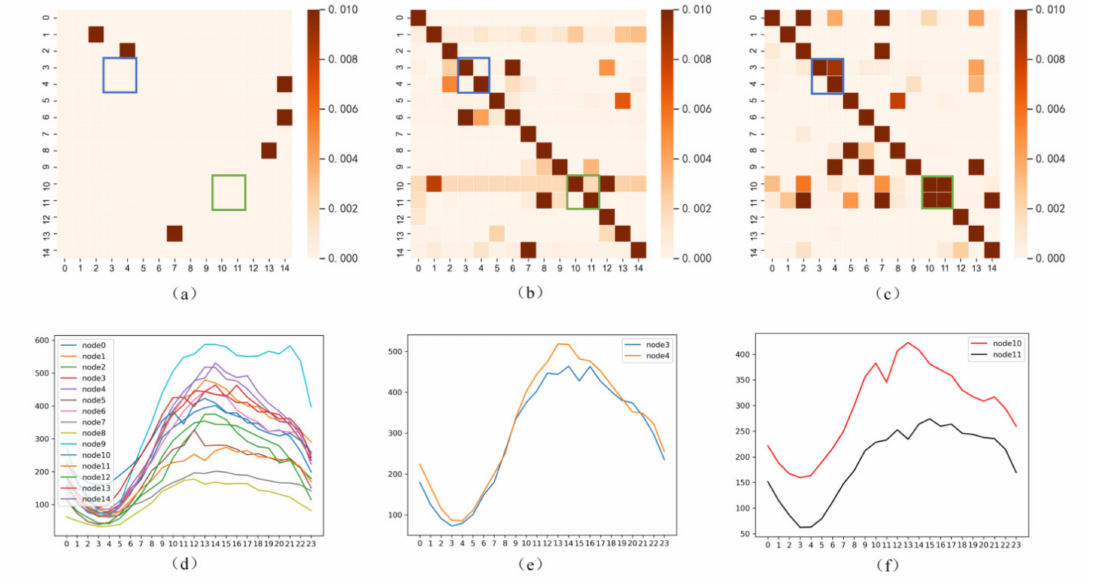
Figure 6. Part of the adjacency matrix at different scales and hourly average traffic flow variation (with PeMS08 as an example). ( a ) Predefined adjacency matrix. ( b ) Self-adaptive adjacency matrix at a single scale. ( c ) Self-adaptive adjacency matrix at multiple scales. ( d ) Hourly flow variation for the first fifteen nodes. ( e ) Hourly traffic variation of node 3 and node 4. ( f ) Hourly traffic variation of node 10 and node